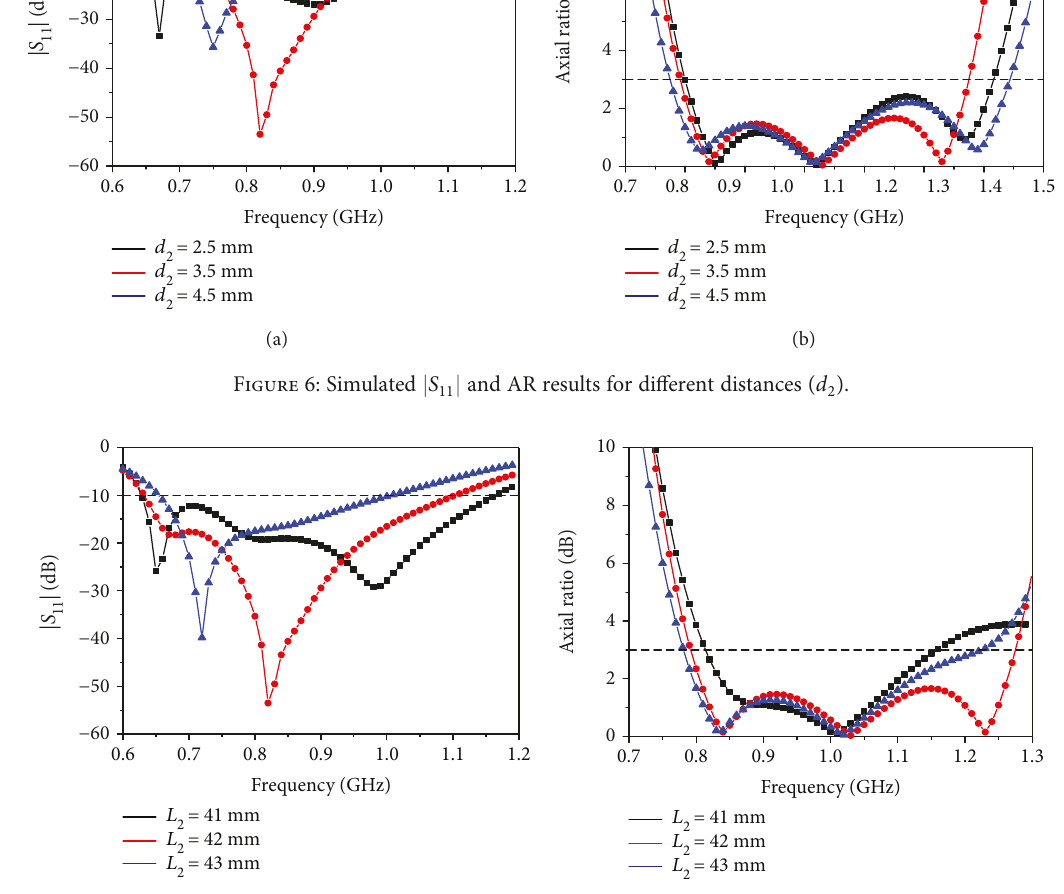
Figure 7: Simulated S